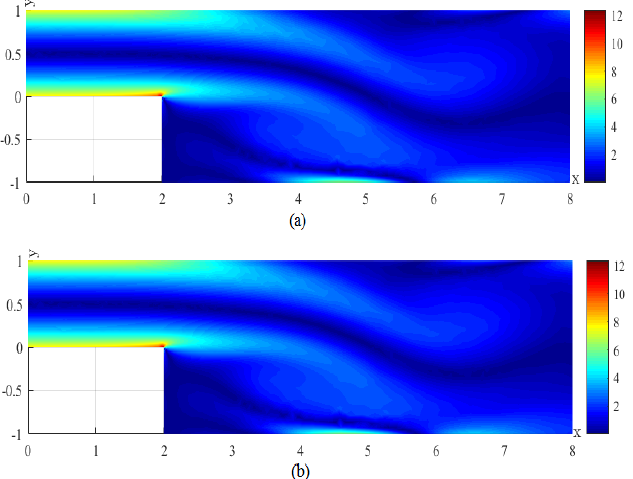
Figure 5. ( a ) The CNMFE solution for p at t = 4. ( b ) The RDRCNMFE solution for p at t =